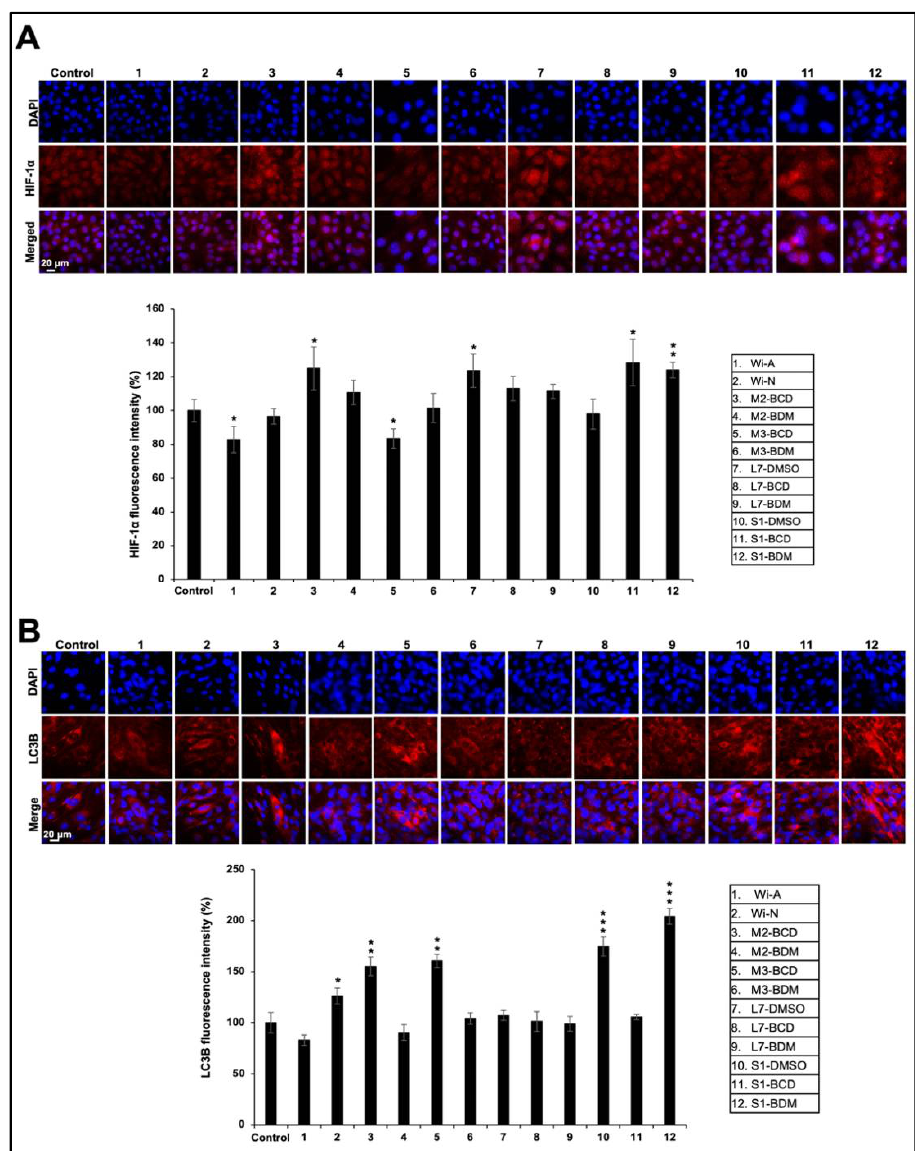
Figure 7. Effect of Ashwagandha extracts and purified withanolides on hypoxia and autophagy. ( A ) HRE-promoter-driven luciferase assay in control and treated cells. ( B ) Western blotting analysis for HIF-1α and LC3B proteins after treatment with Ashwagandha withanolides. Quantitation of the results is shown below (mean ± SD, n = 3), * p  0.05, ** p  0.01, *** p  0.001 (Student’s t -test to control).